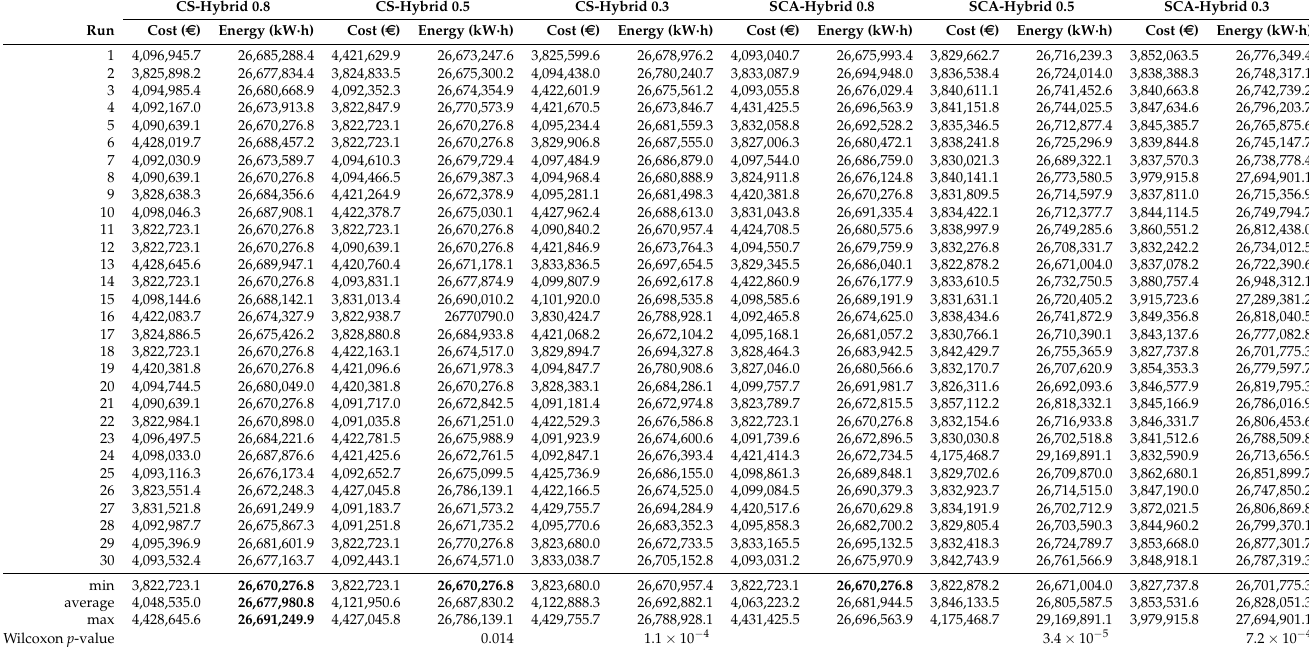
Table 7. Analysis of the β parameter for hybrid CS and hybrid SCA algorithms in the embodied optimization